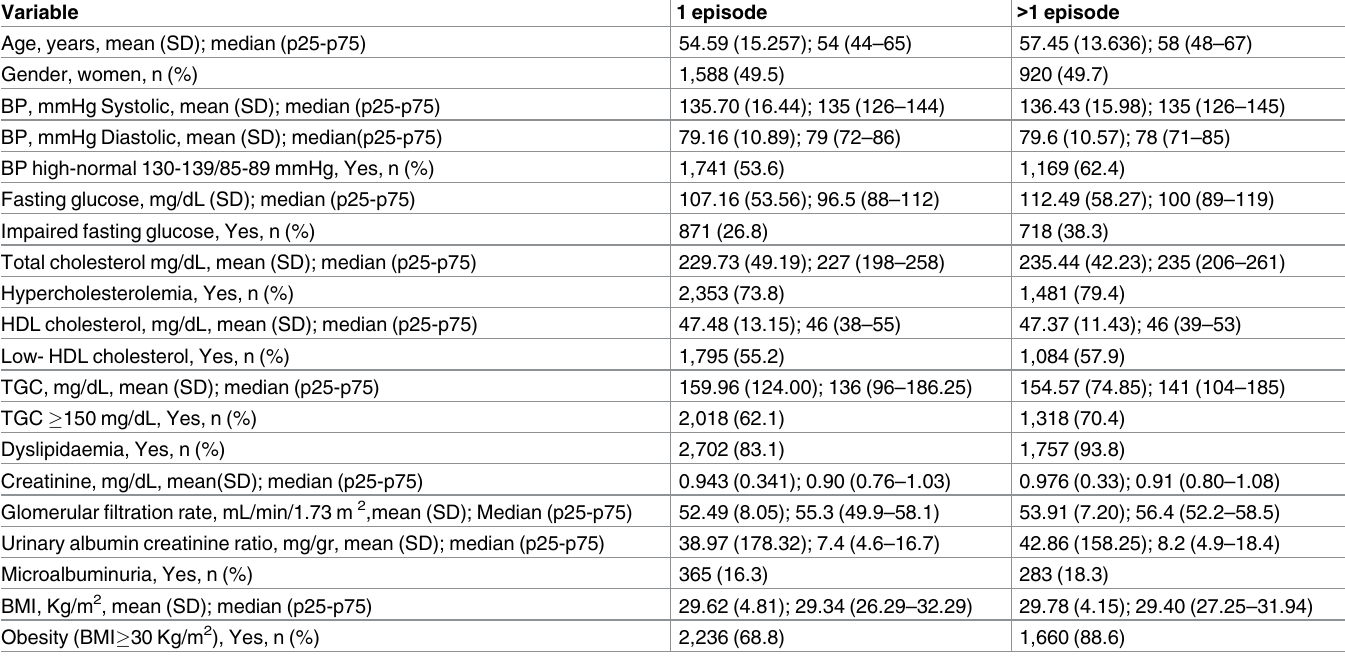
Table 2. Baseline characteristics of participants who developed one or more than one metabolic syndrome